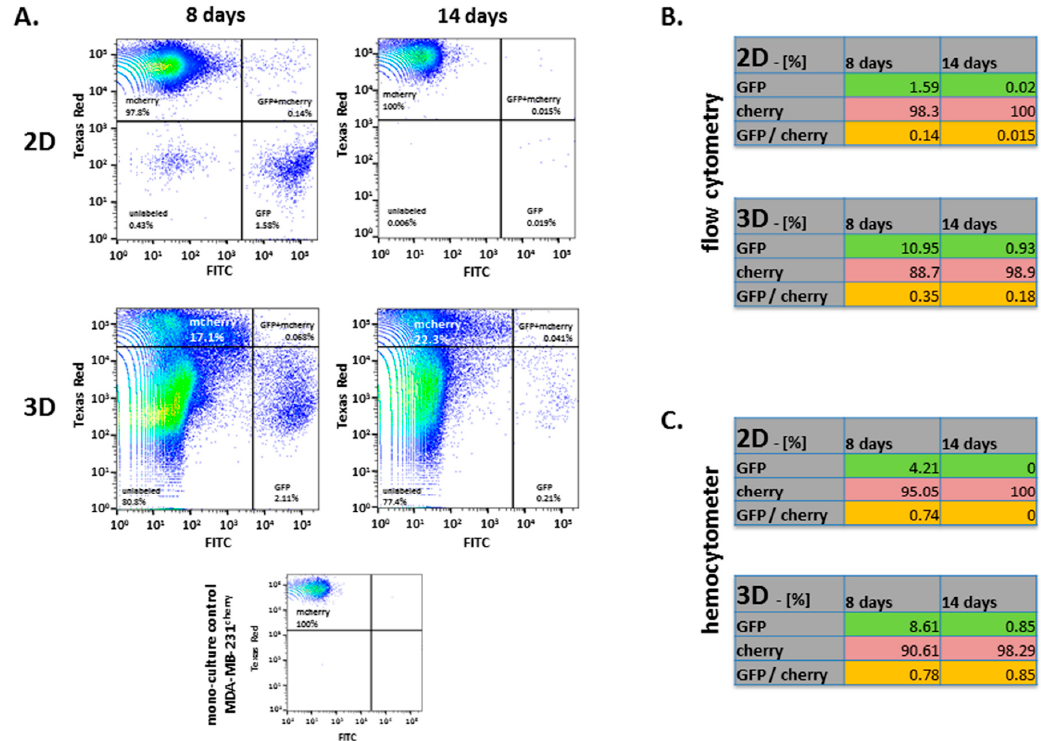
Figure 2. Analysis of GFP, cherry and GFP+cherry fluorescence in 8 and 14 days 2D cultures and ex vivo 3D tumors, including an MDA-MB-231 cherry mono-culture control, were ( A ) examined by flow cytometric analysis and ( B ) the proportions were adjusted to 100% after exclusion of unlabeled cell populations. ( C ) In addition, percentages of GFP and cherry fluorescence were quantified by cell counting in a hemocytometer. All results were compared to the appropriate 2D co-cultures on plastic dishes (Greiner Bio-One, Kremsmünster, Austria).